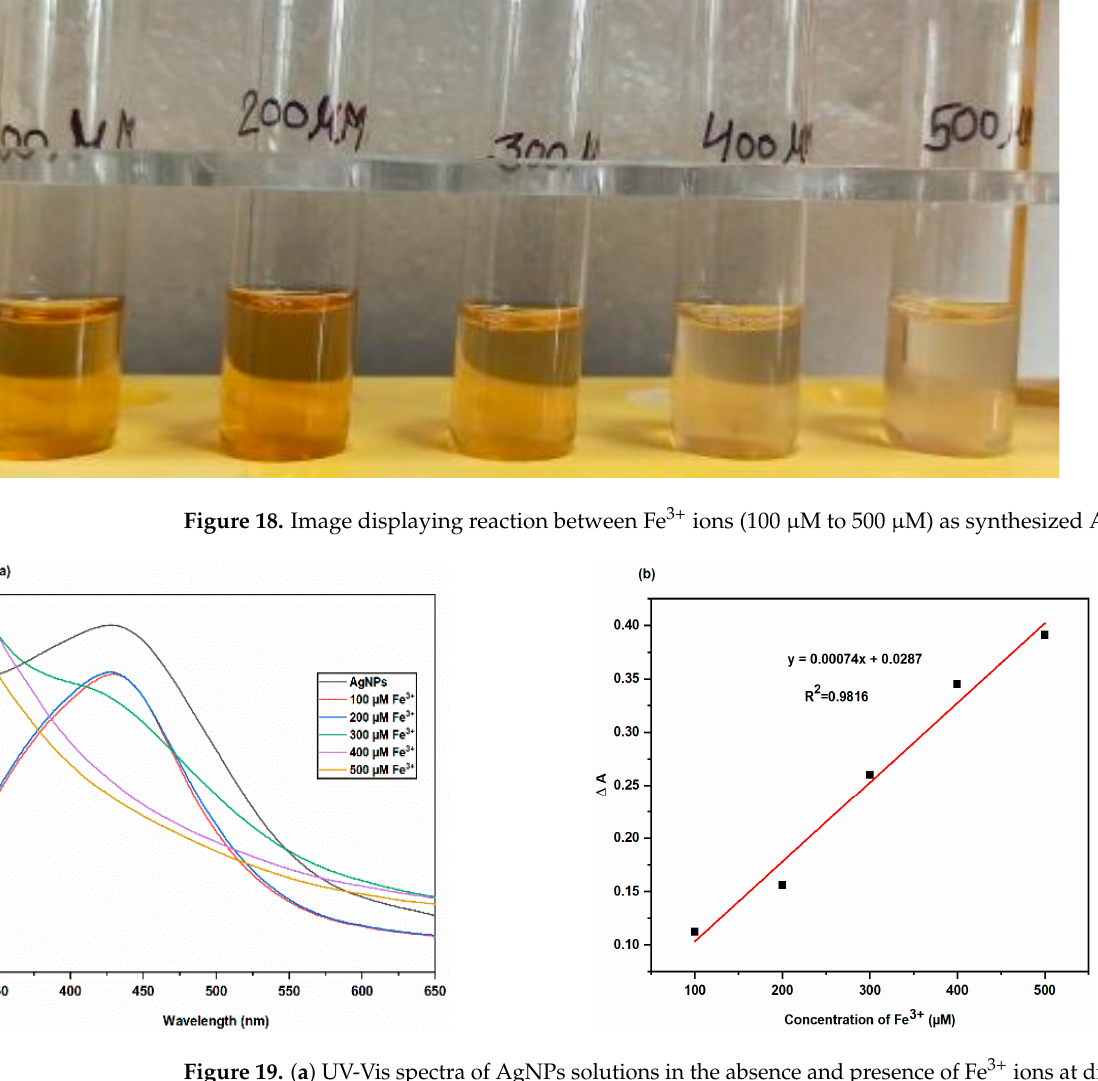
Figure 19. ( a ) UV-Vis spectra of AgNPs solutions in the absence and presence of Fe 3+ ions at different concentrations ( b ) plot of ∆ A values for biosynthesized AgNPs solutions containing Fe 3+ ions at different concentrations versus Fe 3+ concentration.